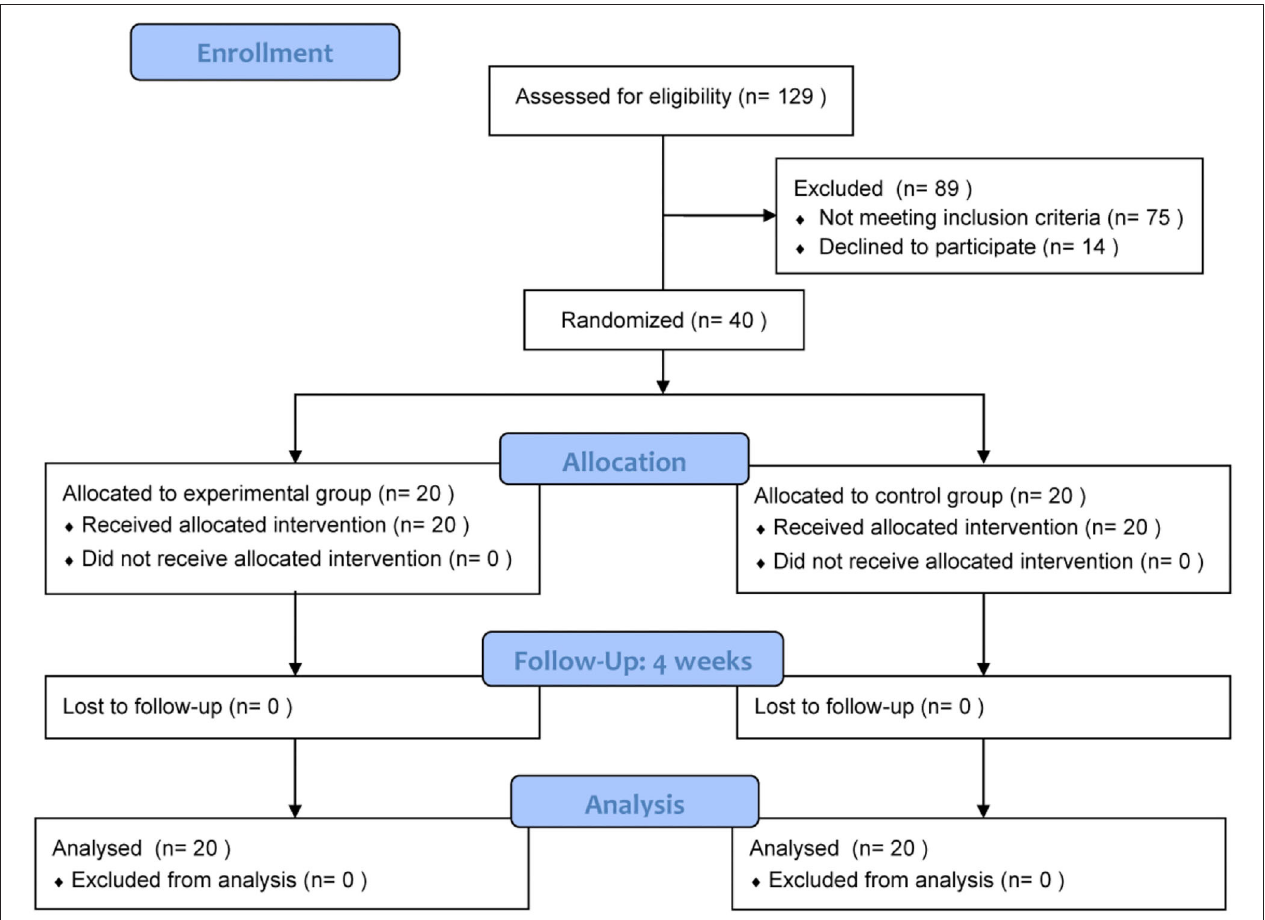
FIGURE 1 | Flow chart of patients through this